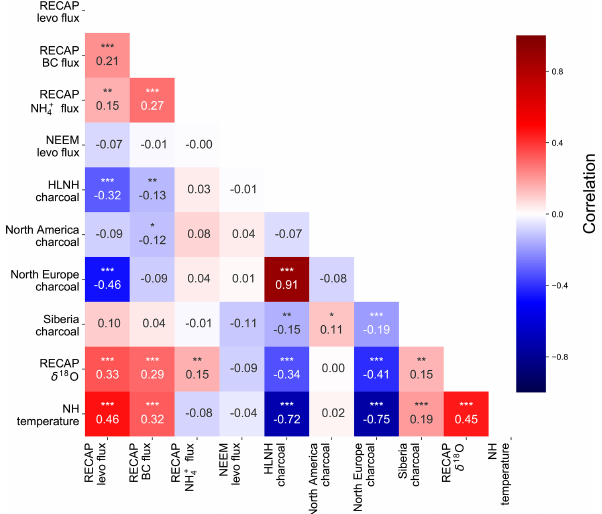
Figure 2. Correlation matrix of 5kyr records with resolution of 20 years. *** indicates p < 0 . 01, ** indicates p < 0 . 05, and * indi- cates p < 0 . 1. The colour bar represents the correlation from − 1 to 1.